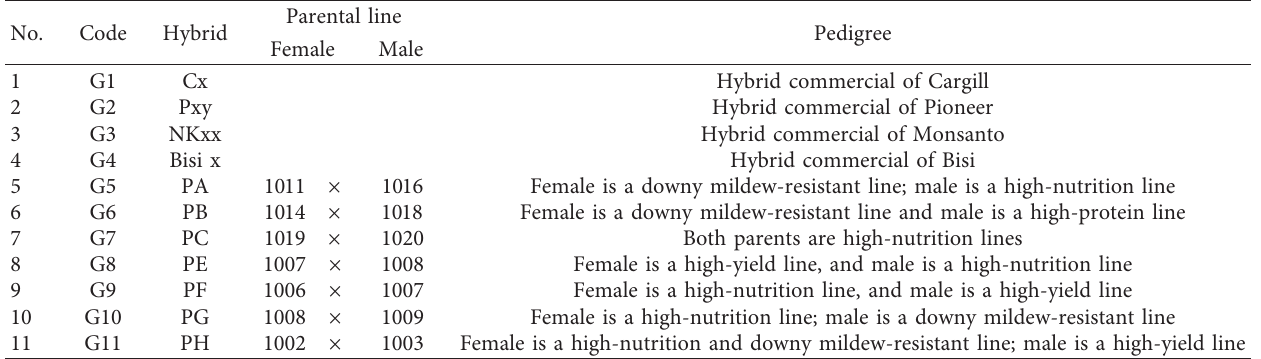
Table 2: The maize hybrids materials and their